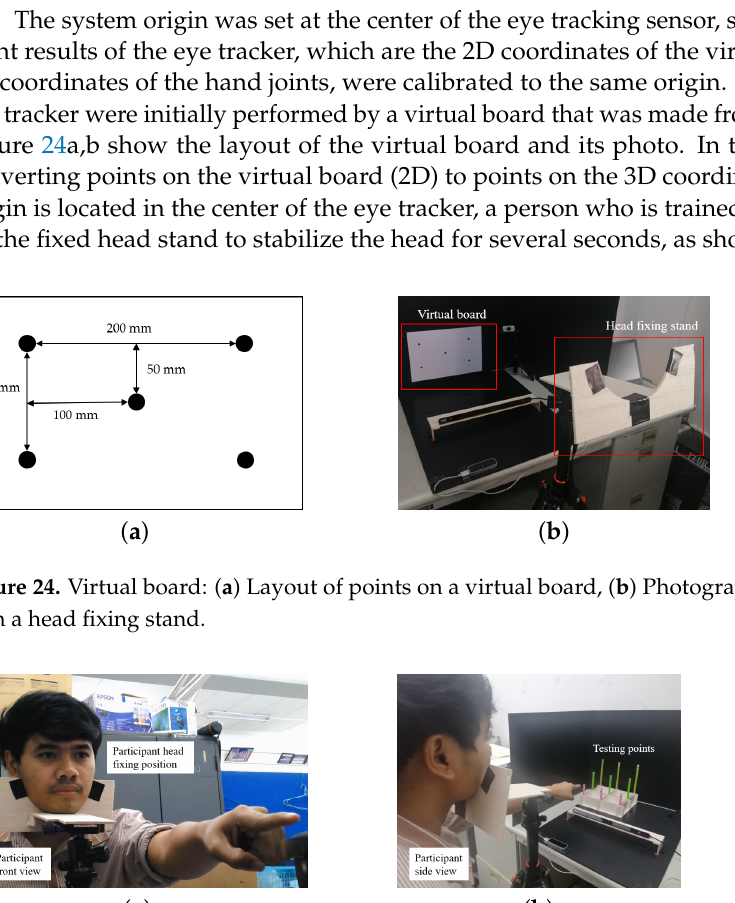
Figure 23. A photograph of an experimental equipment.